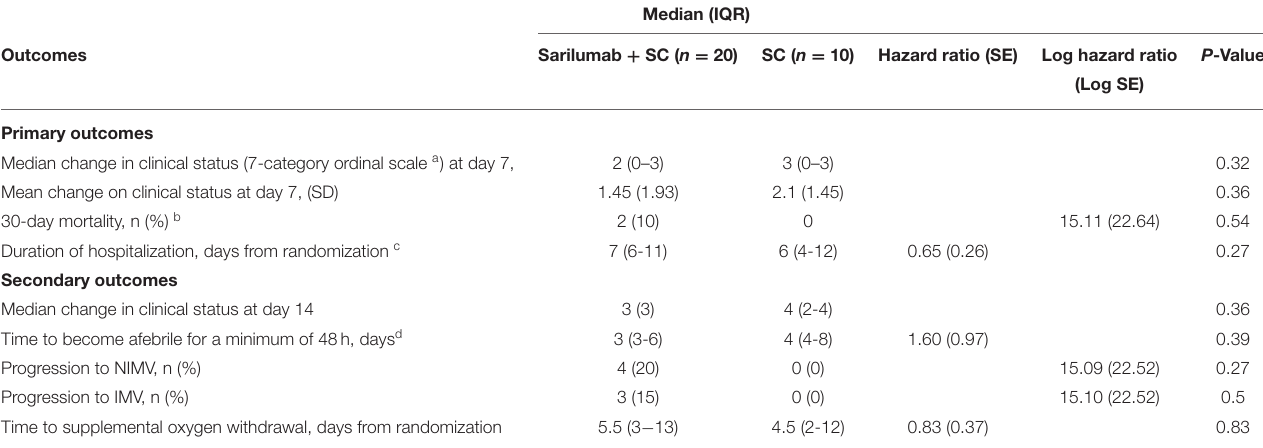
TABLE 3 | Clinical outcomes in the intention-to-treat population.